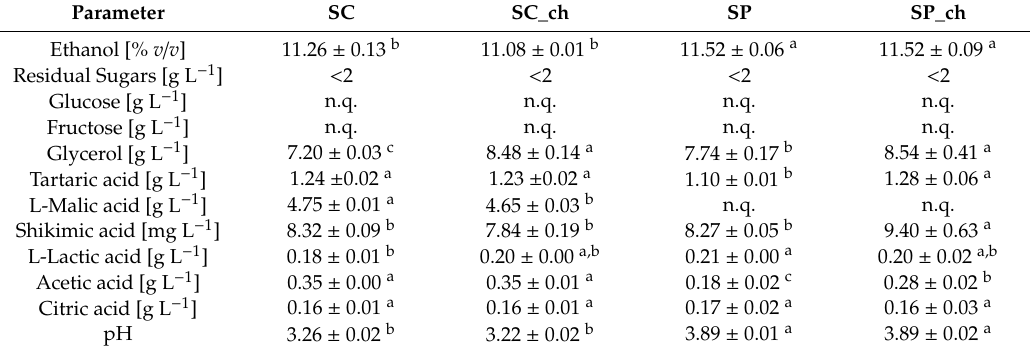
Figure 1. Fermentation kinetics of the variants measured gravimetrically by the total weight loss in the course of the fermentation. SC— Sac. Cerevisiae ; SC_ch— Sac. cerevisiae fermenting with chitosan; SP— Sch. Pombe ; SP_ch— Sch. pombe fermenting with chitosan. The values indicate the mean and Table 1. Final analysis of the basic fermentative parameters—values from wines fermented with Sac. cerevisiae (SC), Sac. cerevisiae fermenting with chitosan (SC_ch), Sch. pombe (SP), and Sch. pombe fermenting with chitosan (SP_ch).